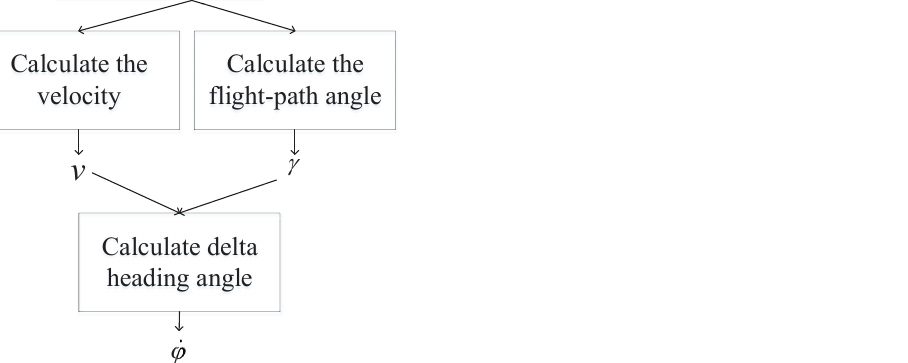
Figure 4. Pre-processing of measurement